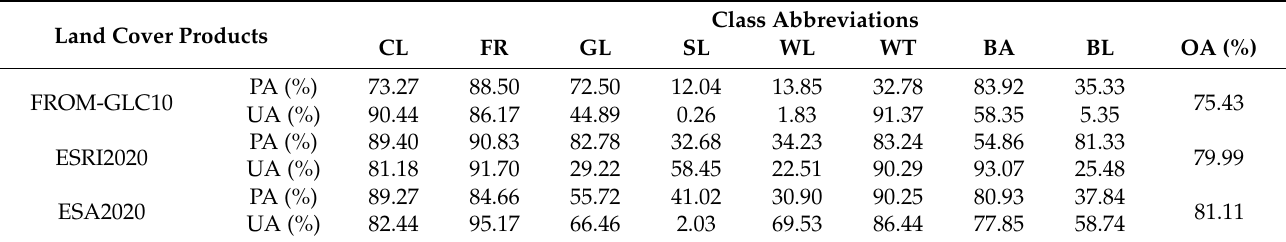
Table 8. Average validation results based on 100 random